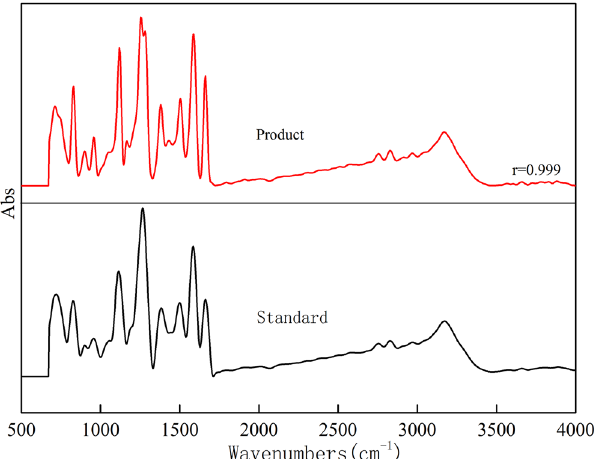
Figure 9. Comparison of IR spectra of disinfection product and standard 5-methy-2-hydroxy